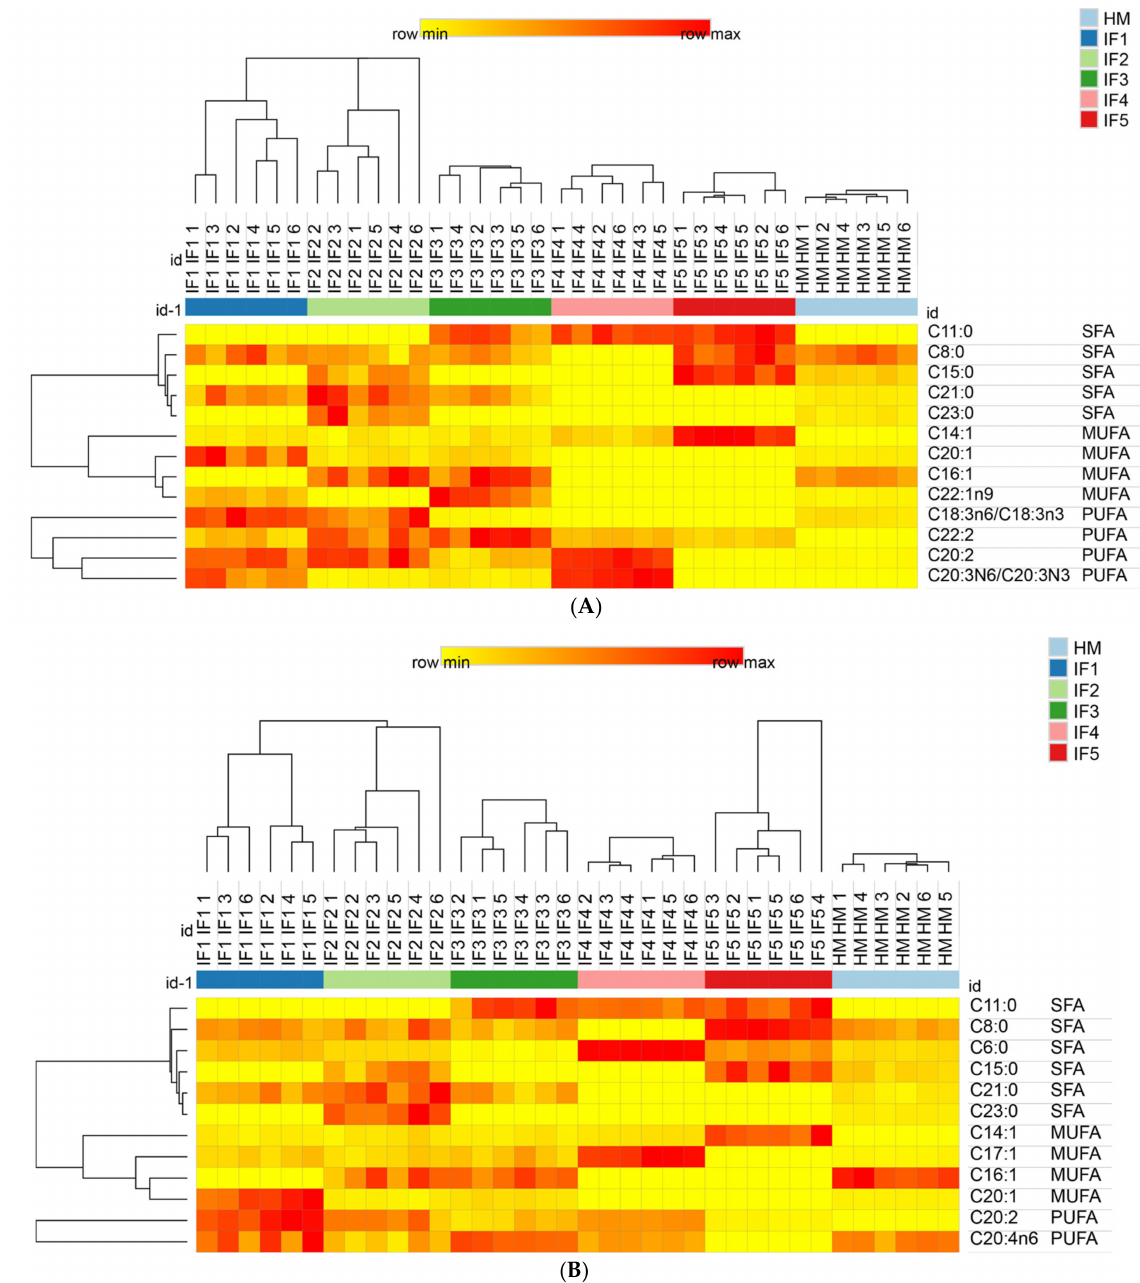
Figure 5. Distributions of differential fatty acids in infant formulas and human milk after gastric digestion ( A ) and intestinal digestion ( B ). IF1: vegetable oil-based formula; IF2: vegetable